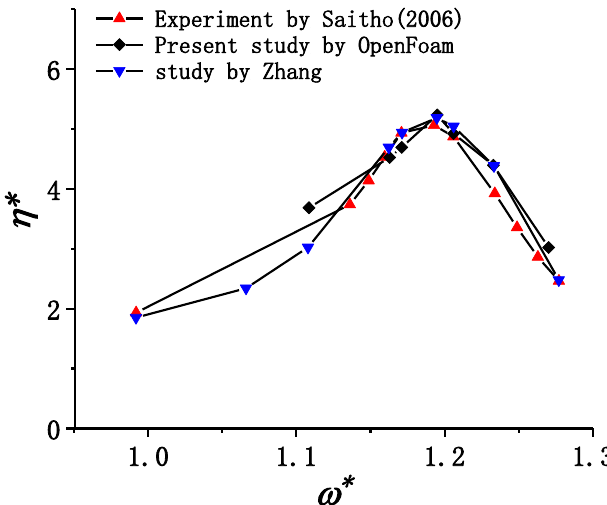
Figure 6. Fluid oscillation amplitudes against angular frequency of incident wave.